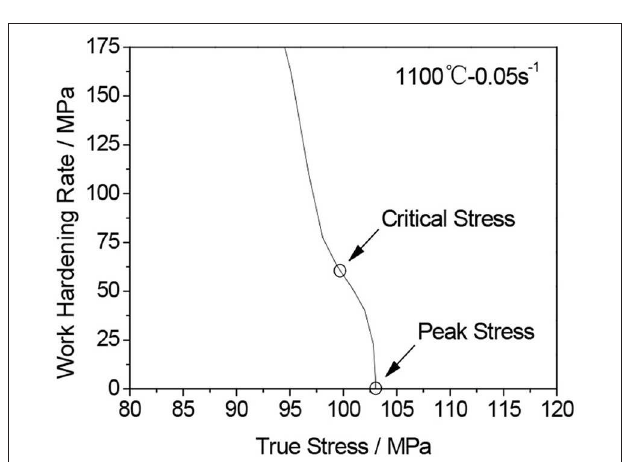
FIGURE 5 | Work hardening rate-true stress curve and method to find characteristic points.